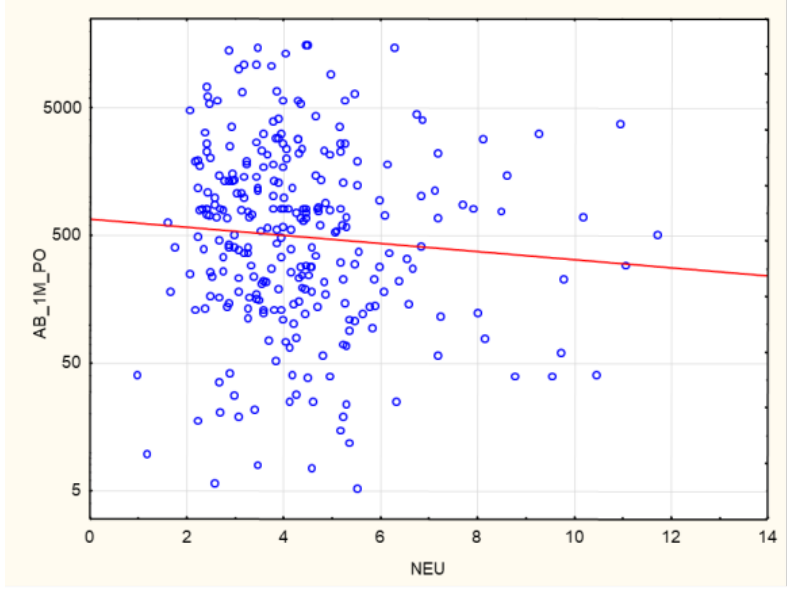
Figure 17. Negative correlation between AB levels (AU/mL) at 1 month after the 2nd dose of SARS-CoV-2 vaccine and neutrophil concentrations (g/L) ( p = 0.03, R − 0.13). Spearman’s rank correlation test. AB: antibody, NEU: neutrophil. A positive correlation was found between post-vaccination AB levels and creatinine concentrations ( p = 0.018, R 0.17). The correlation is statistically significant, although the strength of the relationship between the examined factors was weak (Figure 18).